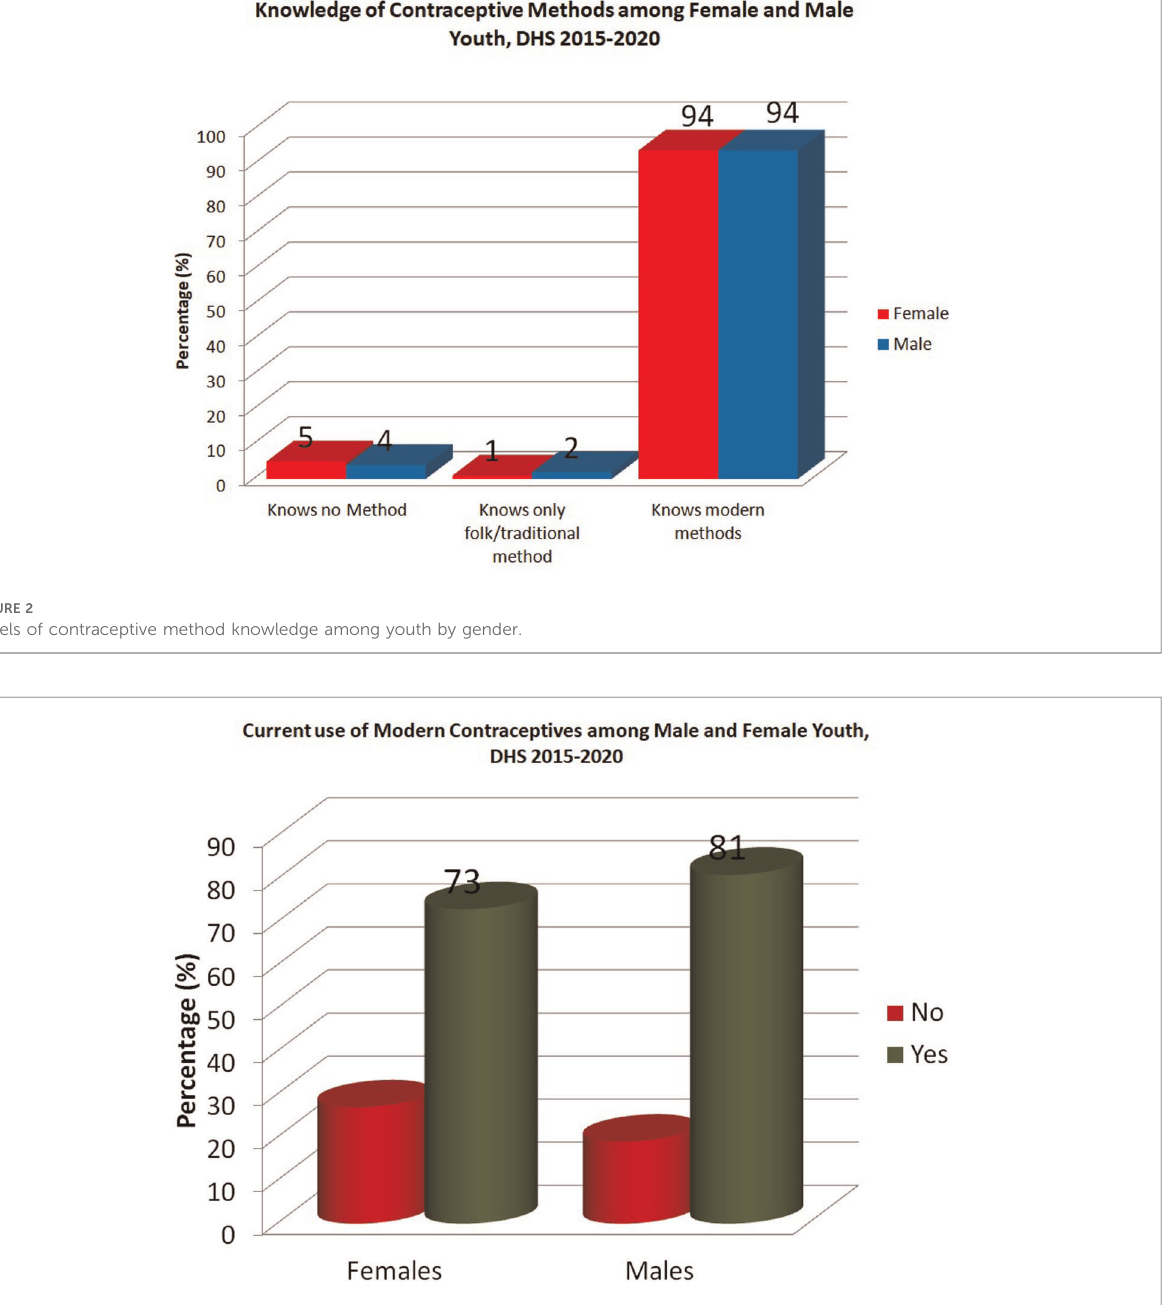
FIGURE 3 Percentage of current use of modern contraceptives by gender among youth in